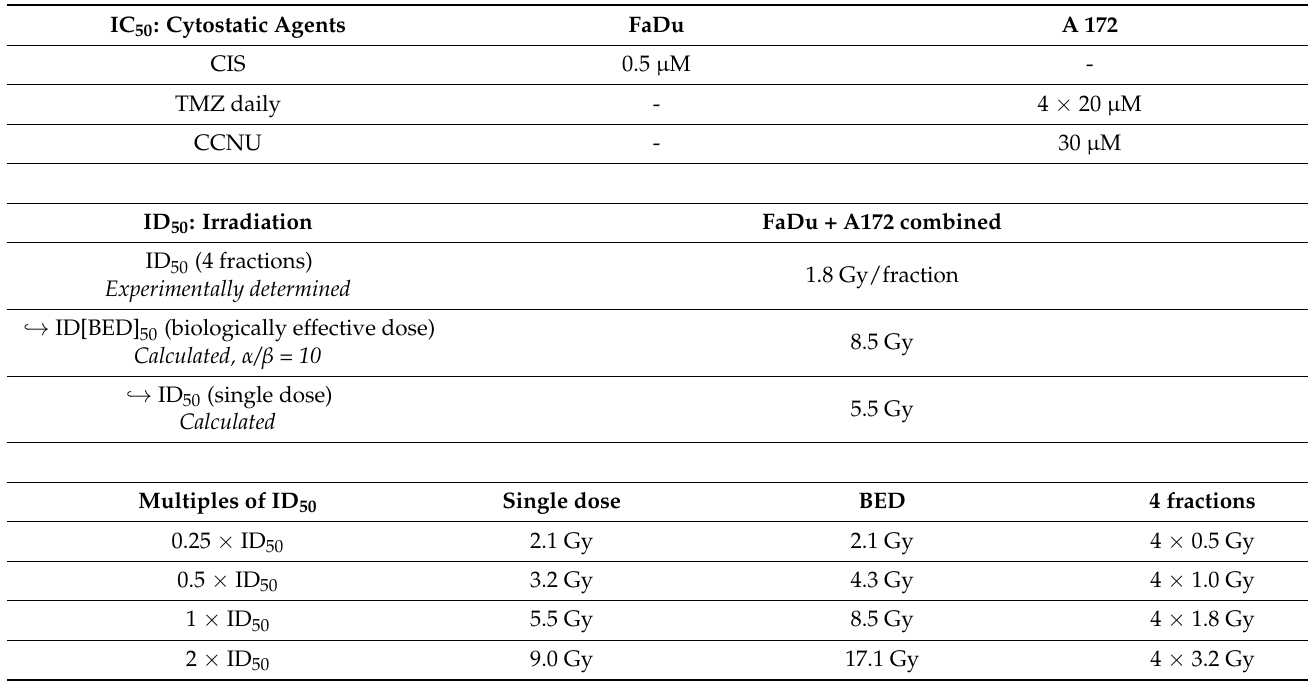
Table 1. Half-maximal inhibitory concentrations (IC 50 ) for cytostatic agents (CIS, TMZ, CCNU) and doses (ID 50 ) for IR (single-dose and fractionated) as determined by WST-1 assay in human tumor cell lines FaDu (HNSCC) and A172 (glioblastoma). For varying IR damage induction, multiples of ID 50 were calculated from multiples of ID[BED] 50 (see Section 4) using linear–quadratic model and are listed